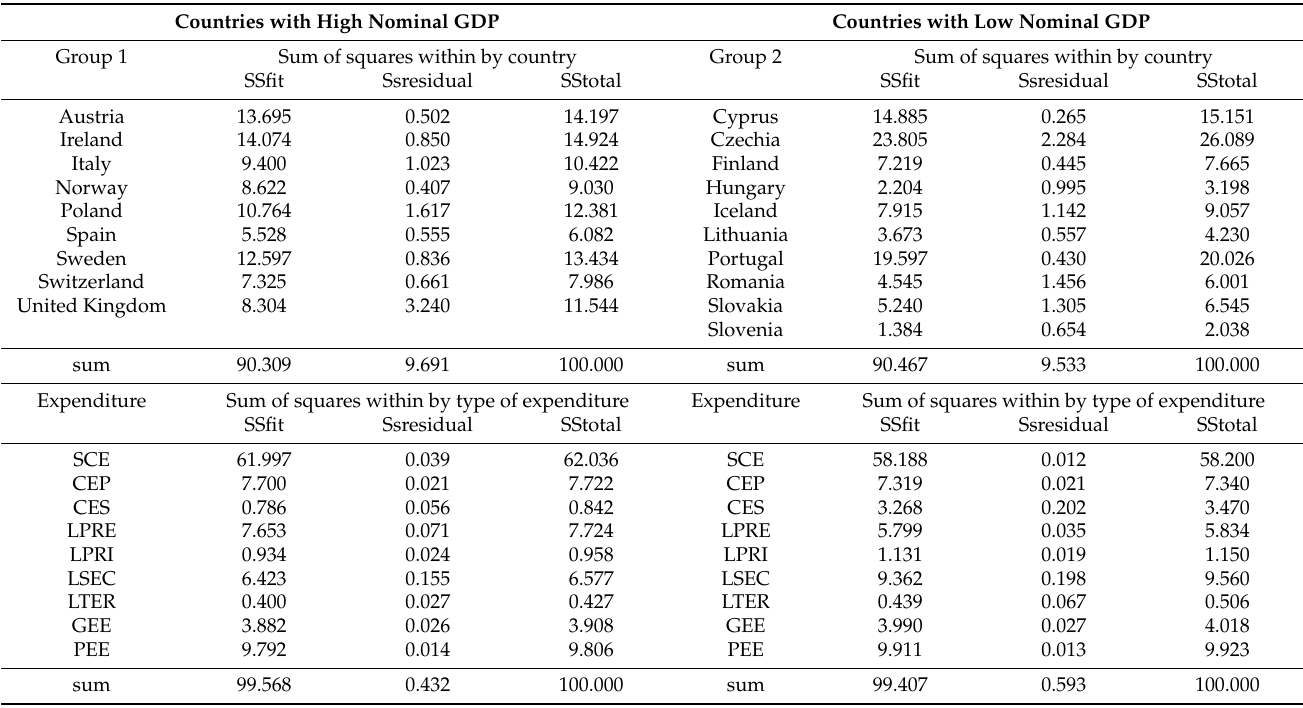
Table 2. Procrustes analysis of variance